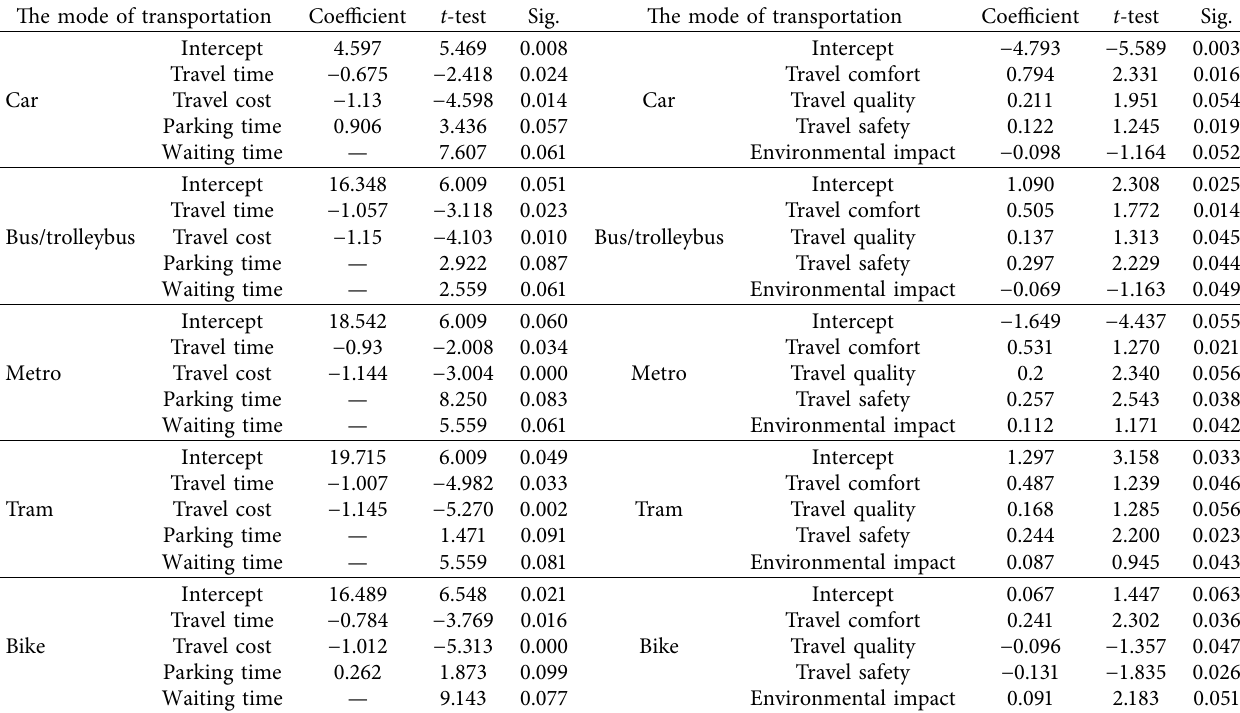
Table 9: The estimation coefficients of the